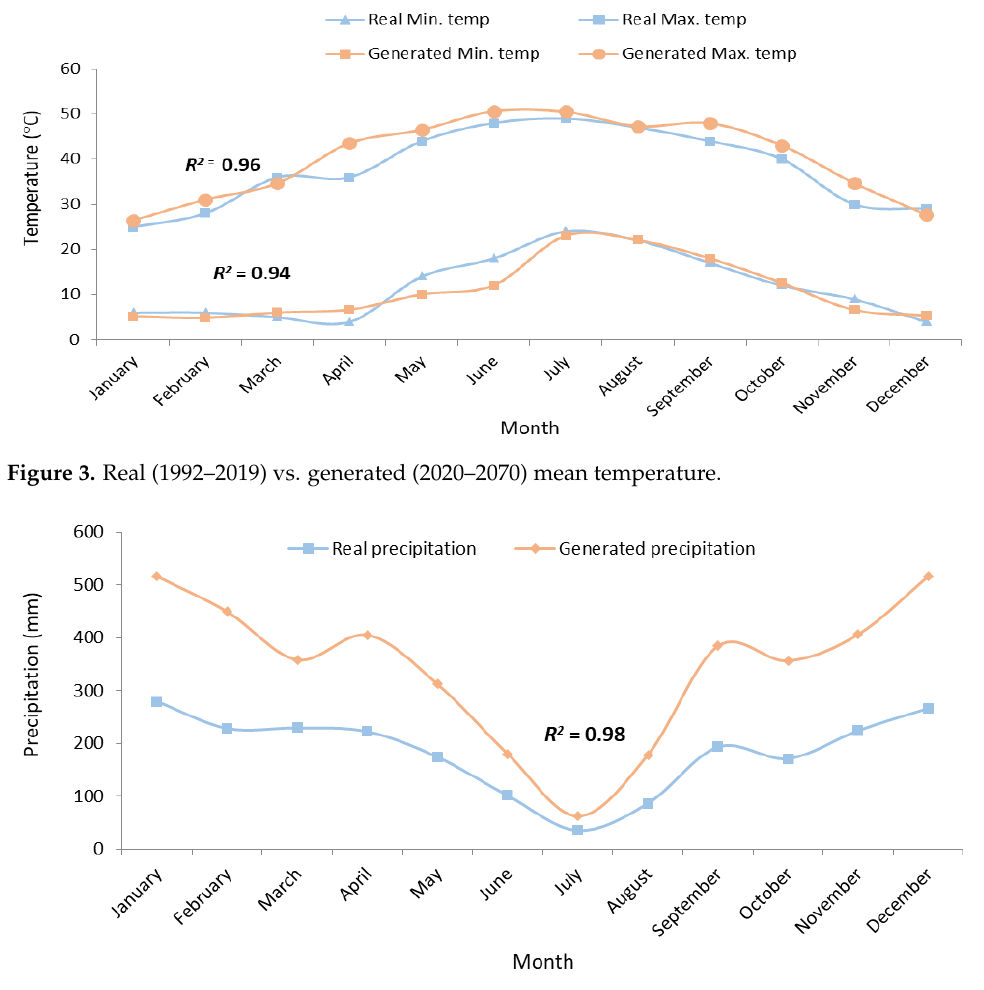
Figure 4. Real (1992 – 2019) vs. generated (2020 – 2070) precipitation.